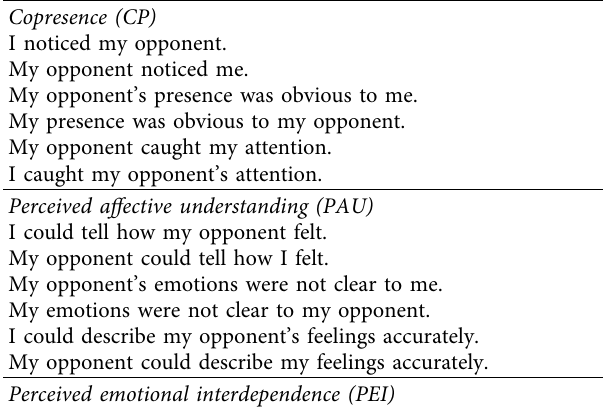
Table 1: Social presence questionnaire [14]. Items range from 1 to 7. Copresence (CP)